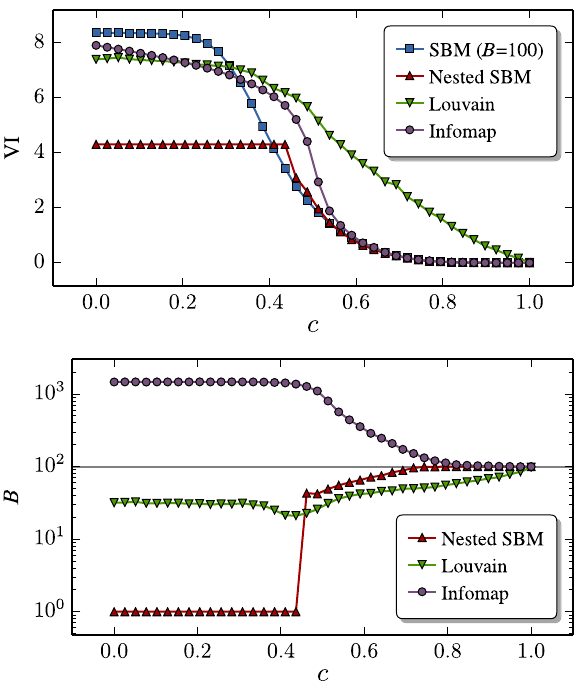
FIG. 9. Top: Variation of information (VI) between the planted and obtained partitions as a function of the assortativity parameter c , for networks with N ¼ 2 × 10 4 , generated as described in the text. The legend indicates results obtained with different meth- ods: Fitting the degree-corrected stochastic block model with a fixed number of blocks B ¼ 100 (SBM), performing model selection with the nested stochastic block model (Nested SBM), the Louvain modularity maximization method [12], and the Infomod method [45,92,93]. Bottom: The obtained number of blocks B as a function of c , for the same methods as in the top panel. The gray horizontal line marks the planted B ¼ 100 value. All results were obtained by averaging over 20 network